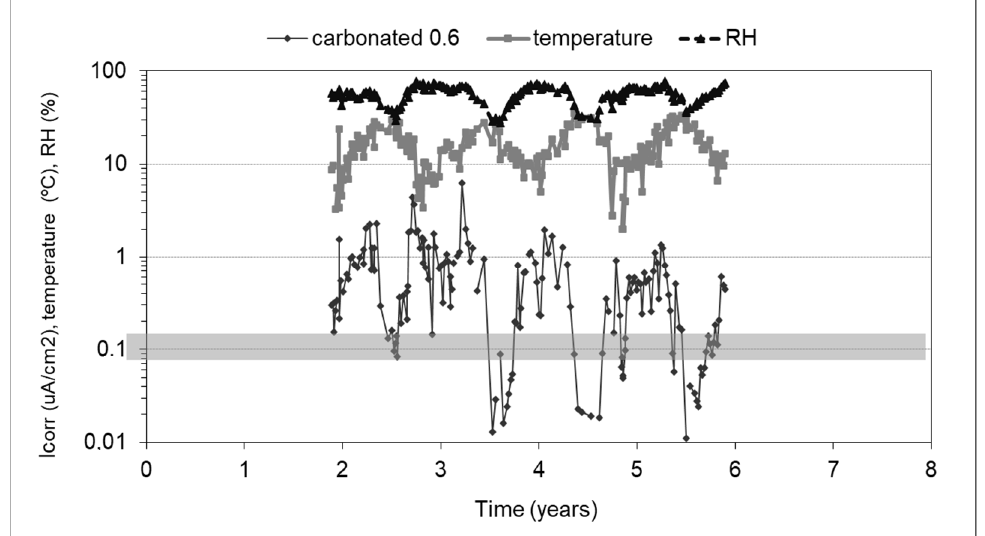
Figure 2. Evolution of the corrosion rate, the temperature and the Relative Humidity in a carbonated specimen exposed outdoors, not sheltered from